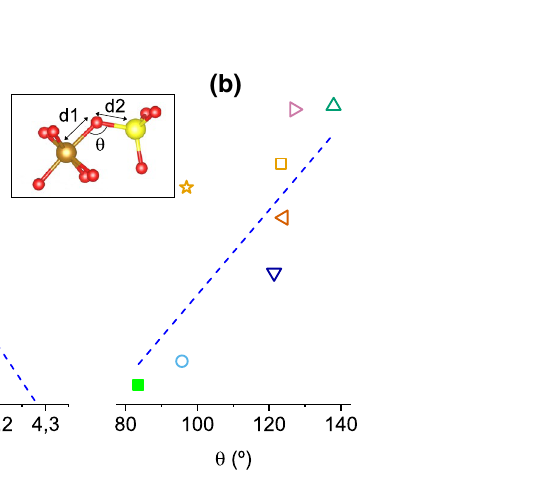
Figure 4. Dependence of the most relevant exchange coupling constants, J ij , on the Hubbard parameter U for the ES case.